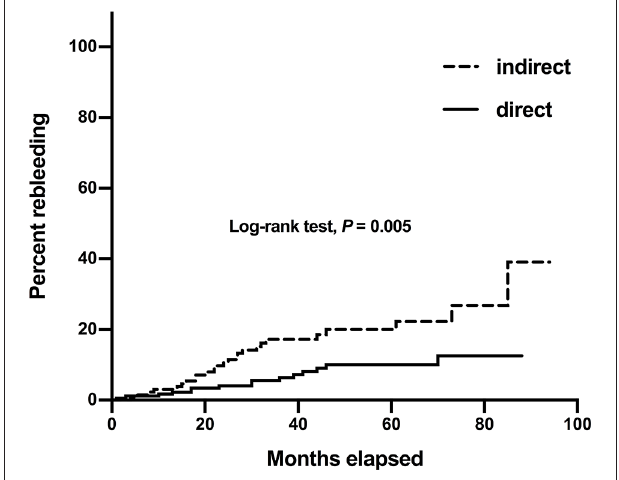
FIGURE 2 | Kaplan–Meier curves for rebleeding incidence in 308 hemorrhagic hemispheres with different revascularization surgery.